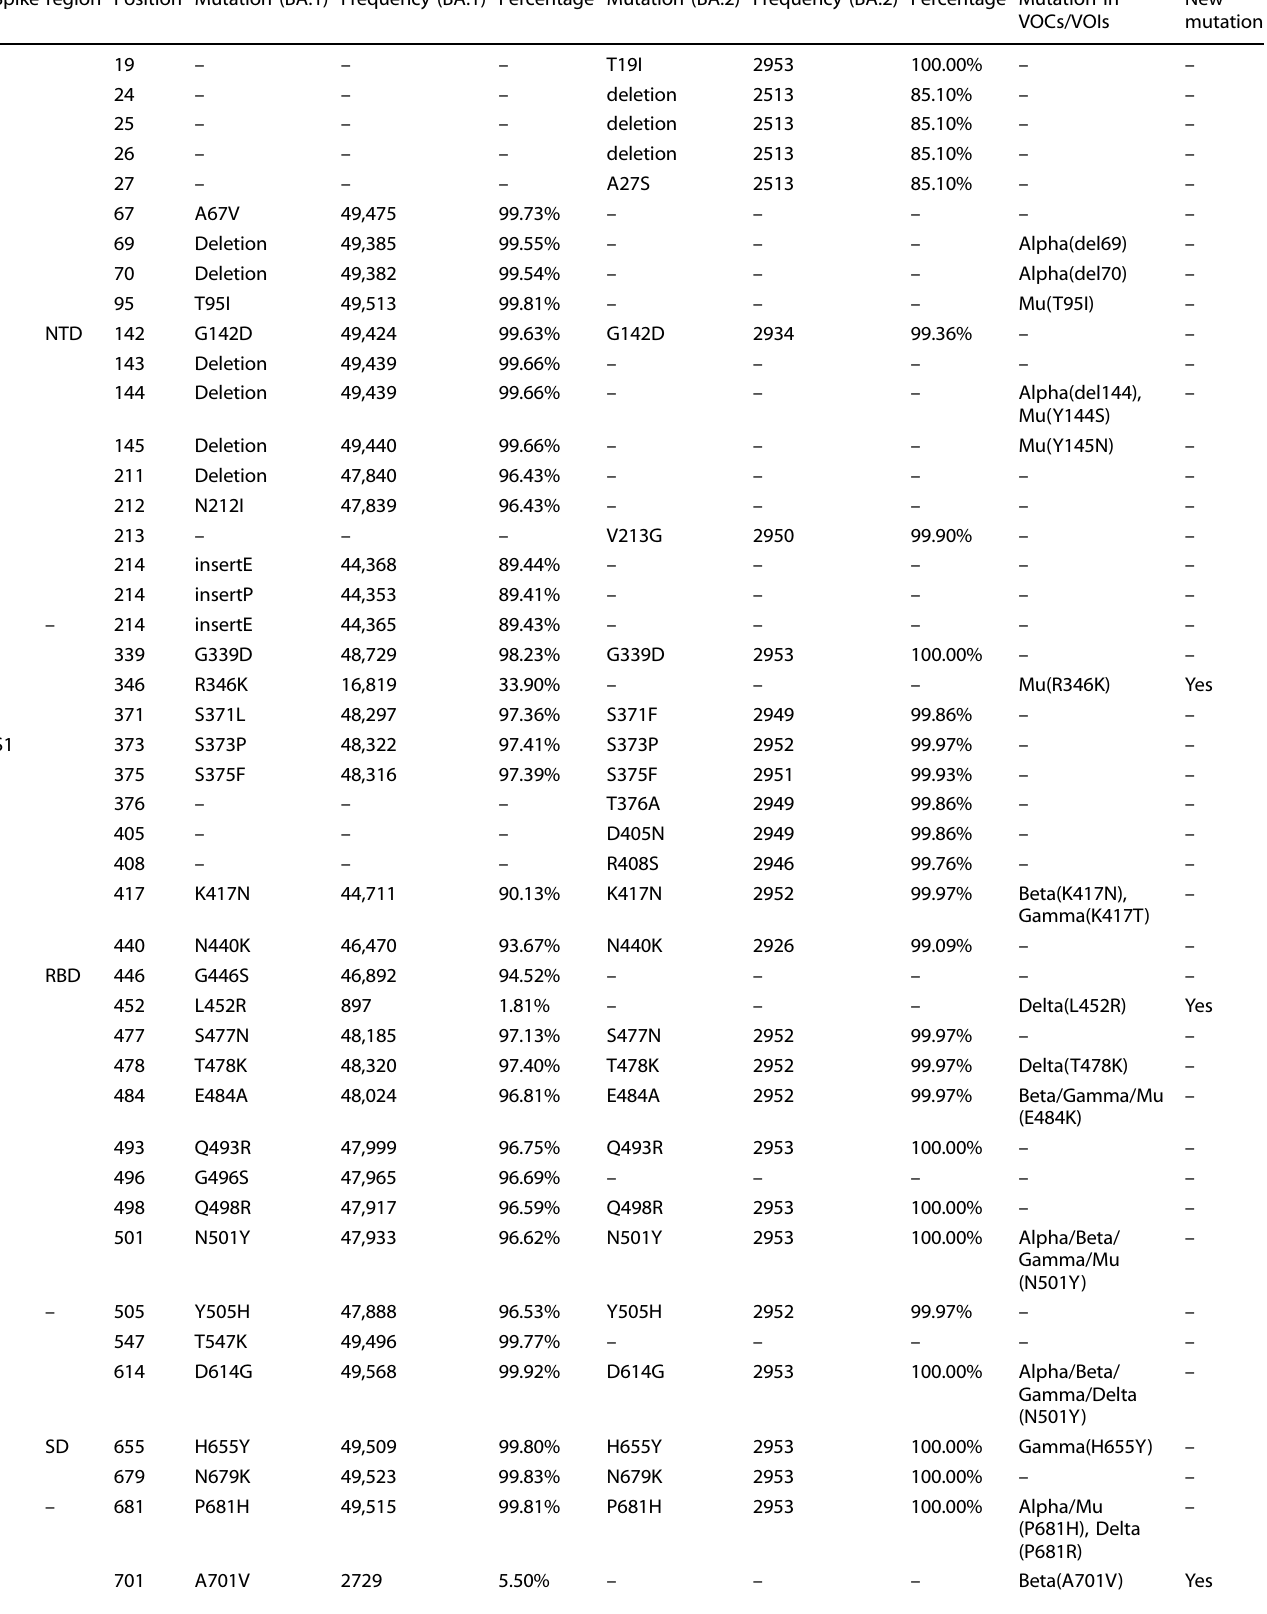
Table 1. Comparison of Spike protein amino acid mutations between the Omicron subvariants and other VOCs and